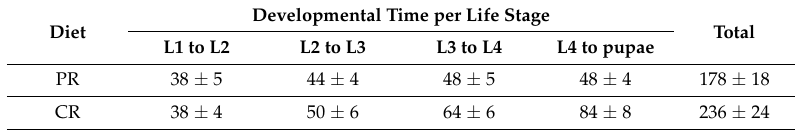
Table 2. Means (hr ± SD) of CR larval diet developmental time compared to larvae reared on PR diet. Larvae were hatched from the same batch of eggs and reared under same conditions. Both sets were given equal amounts (by weight) of food ( n = 6 cohorts of 100